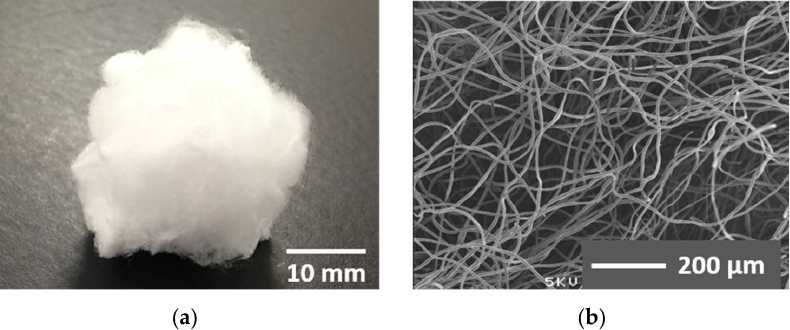
Figure 1. ( a ) Entire view of the cotton ‐ wool ‐ like material prepared using a coaxial electrospinning method; ( b ) SEM image of the material.